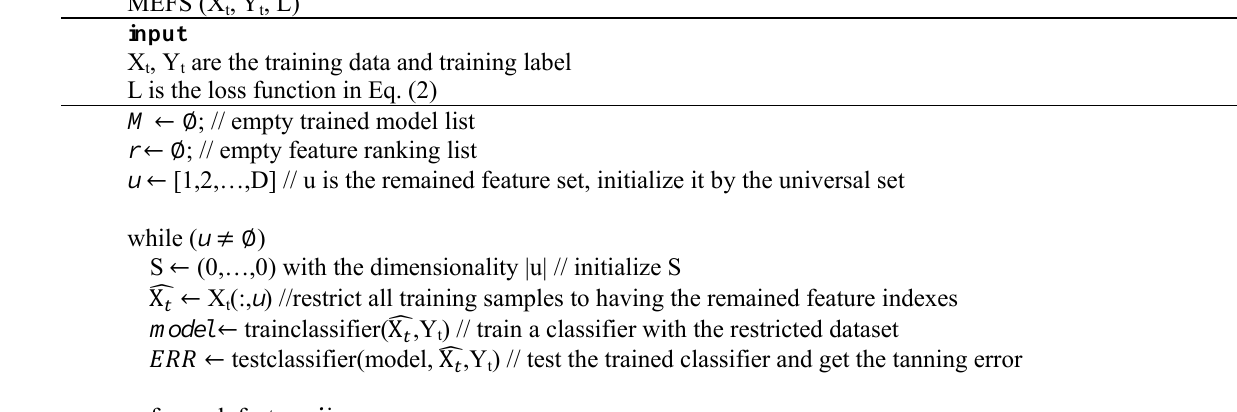
Table 2. Pseudo code of